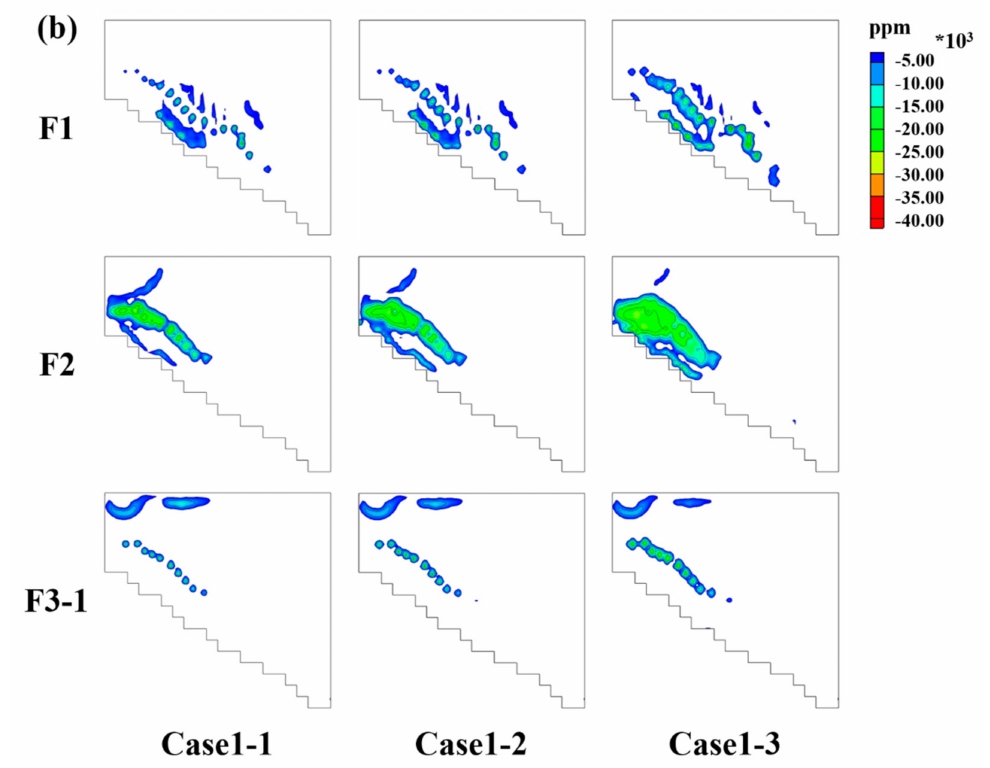
Figure 9. The optimized results in management Scenario #1: ( a ) the simulated TDS concentrations after 20-year of remediation using identified optimal injection strategy #1; and ( b ) the difference of concentrations between 20-year of remediation and the initial